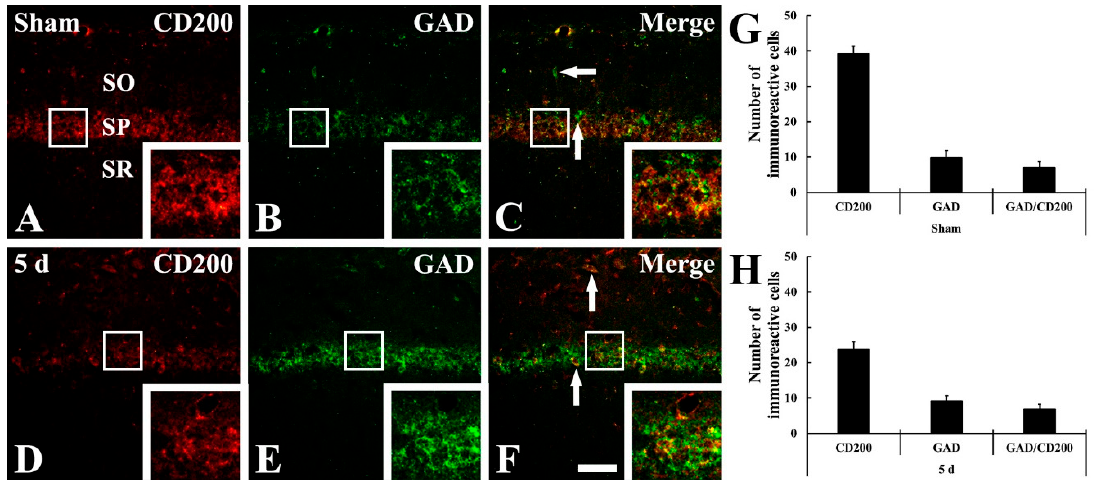
Figure 7. ( A – F ) Double immunofluorescence staining for CD200 (red, ( A , D )), GAD65/67 (green, ( B , E )), and merged images ( C , F ) in the CA1 field of the sham group ( A – C ) and ischemia group ( D – F ) groups at 5 days after tFI. GAD65/67-immuno- reactive GABAergic interneurons (arrows) show CD200 immunoreactivity in both sham and ischemia groups. Scale bar = 50 µm. ( G , H ) Analyses of the numbers of CD200 immunoreactive cells, GAD65/67 immunoreactive GABAergic interneu- rons, and GAD65/67 immunoreactive GABAergic interneurons among CD200 immunoreactive cells in the sham group ( G ) and ischemia group ( H ).